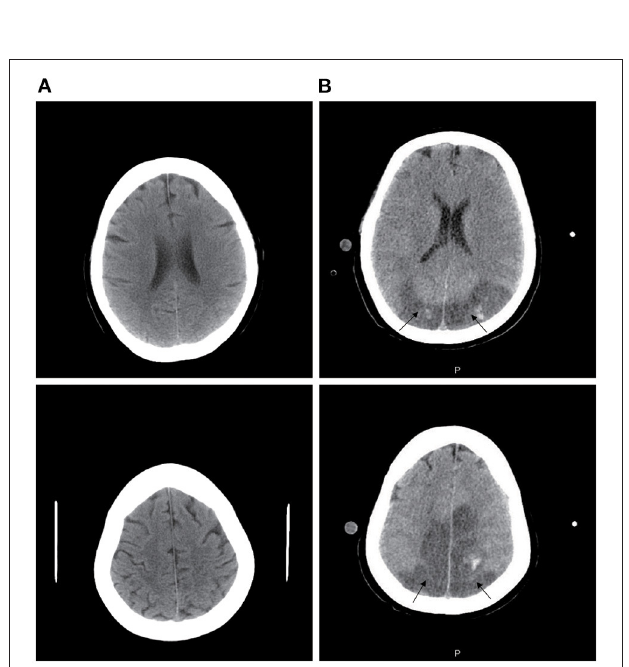
FIGURE 3 | Computed tomography (CT) image of the head. (A) CT of the head is normal at the ECMO stage. (B) CT of the head shows bilateral parieto-occipital low-density lesions at day 3 after transplantation (arrowheads).